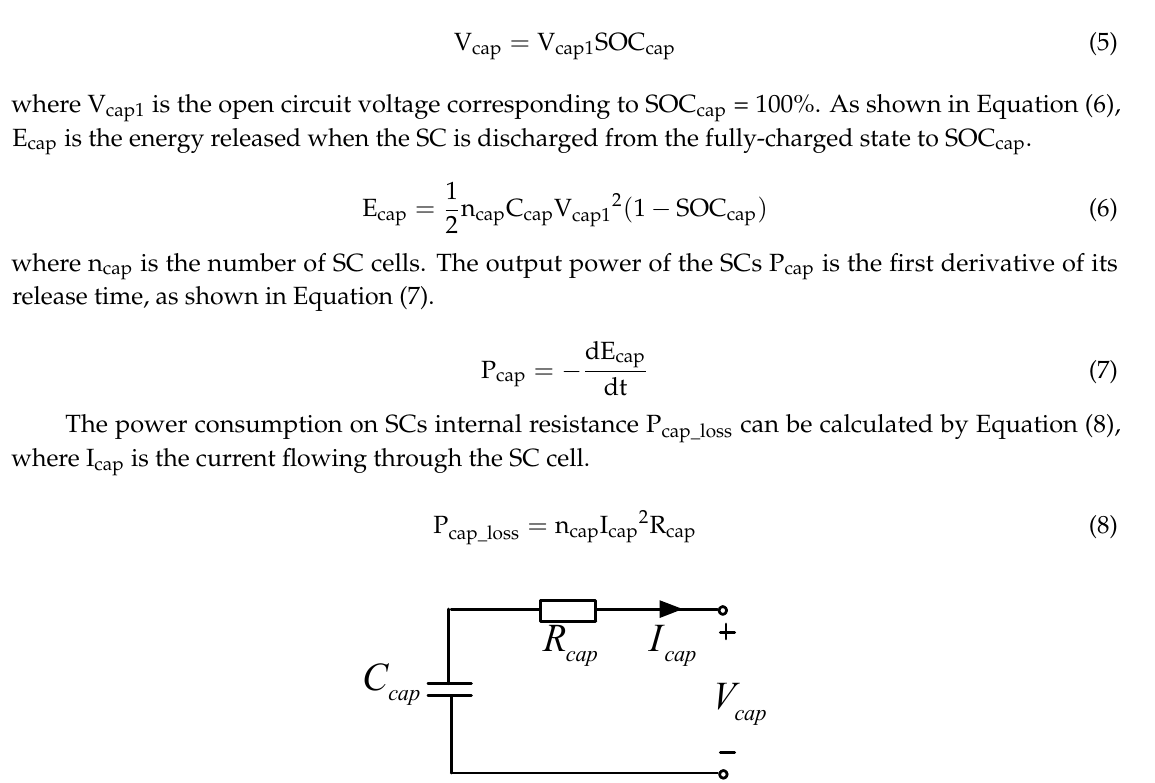
Figure 6. Equivalent circuit modelof the SC.